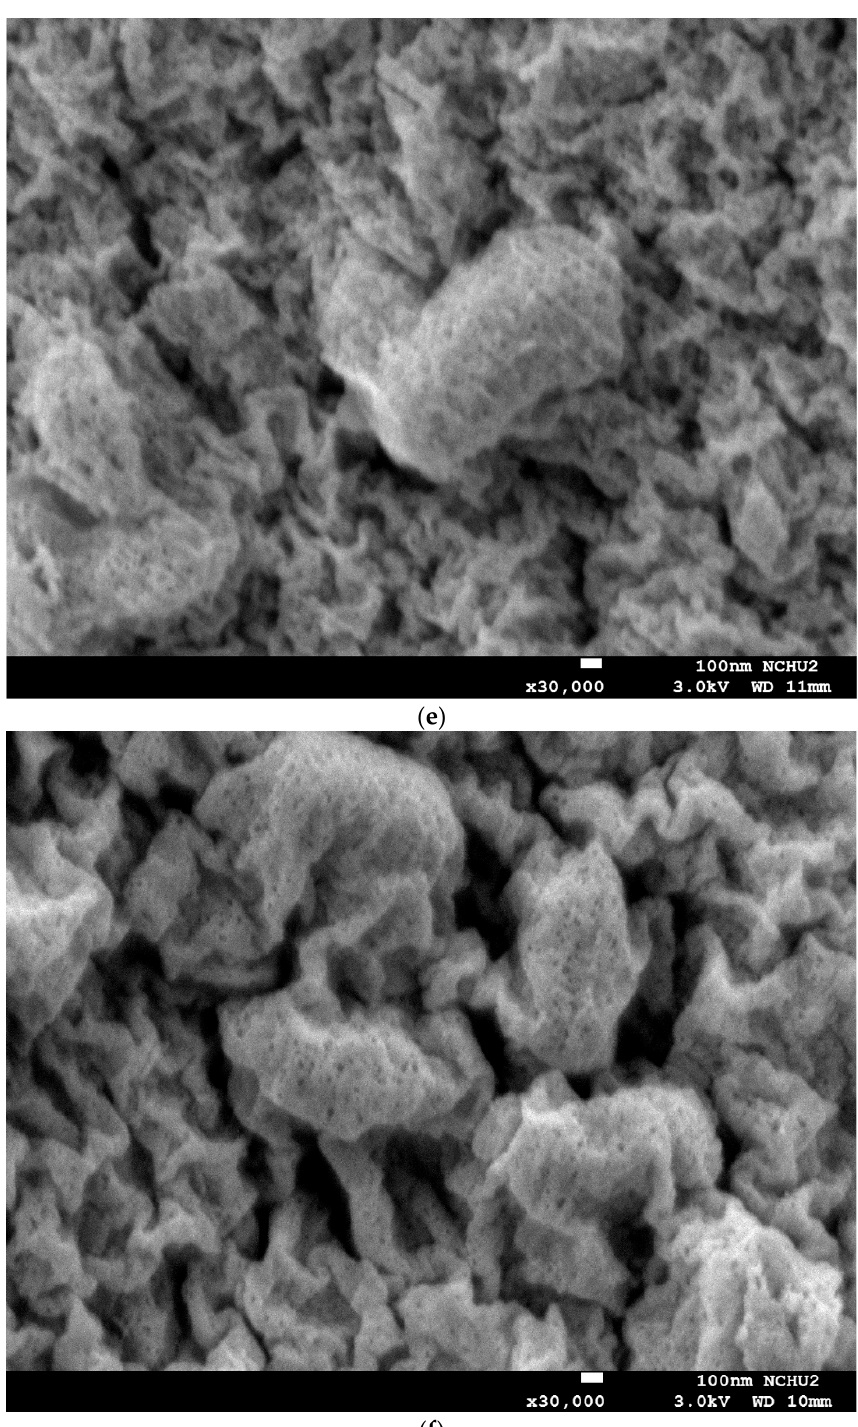
Figure 2. FE-SEM images of capsules loaded with L. plantarum BCRC 10357 by using different concentrations of sodium alginate (% ALG): ( a ) 2% ALG capsule (×5000), ( b ) 3% ALG capsule (×5000), ( c ) 4% ALG capsule (×5000), ( d ) bacteria embedded in 2% ALG capsule (×30,000), ( e ) bacteria embedded in 3% ALG capsule (×30,000), ( f ) bacteria embedded in 4% ALG capsule (×30,000).